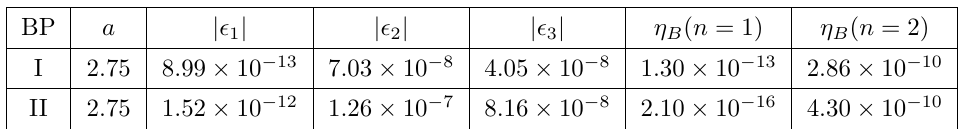
Table 5 . Estimation of baryon asymmetry considering uncompressed mass hierarchy with M φ { 10 7 , 10 9 , 10 11 } GeV for the two benchmark points in table